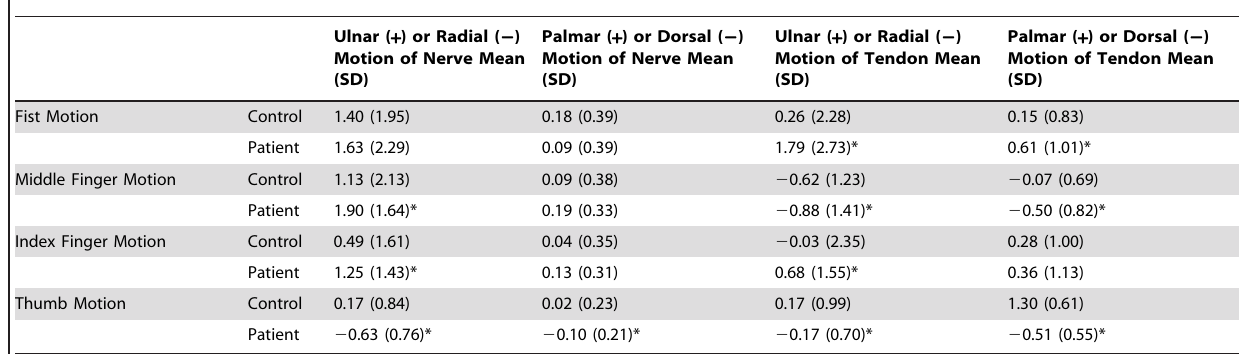
Table 1. Motion of the median nerve, flexor digitorum superficialis tendons and the flexor pollicis longus tendon.